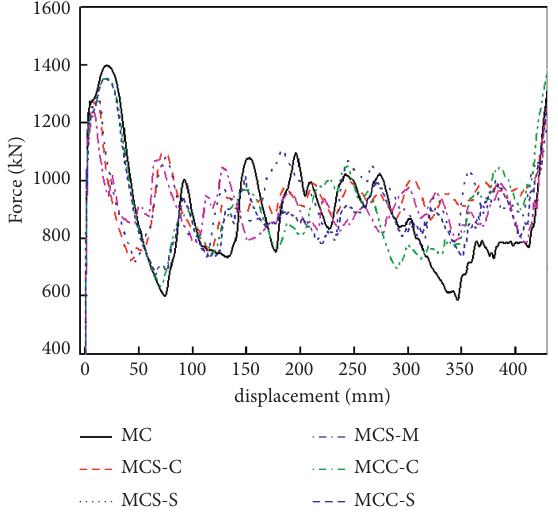
Figure 9: Force-displacement curves of different